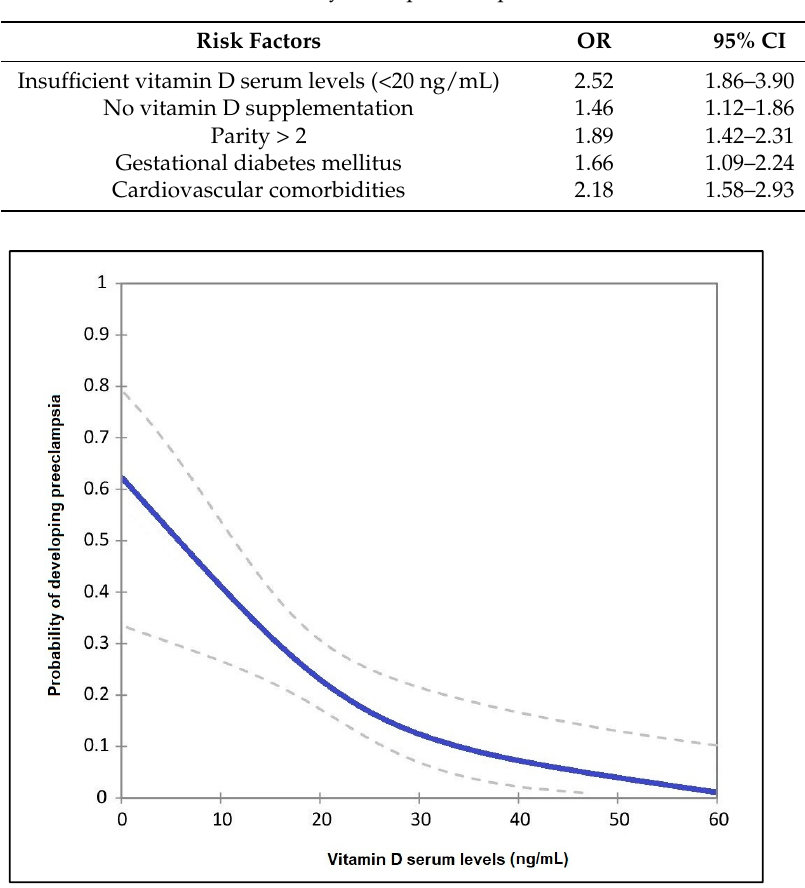
Table 5. Maternal risk factor analysis for preeclampsia.